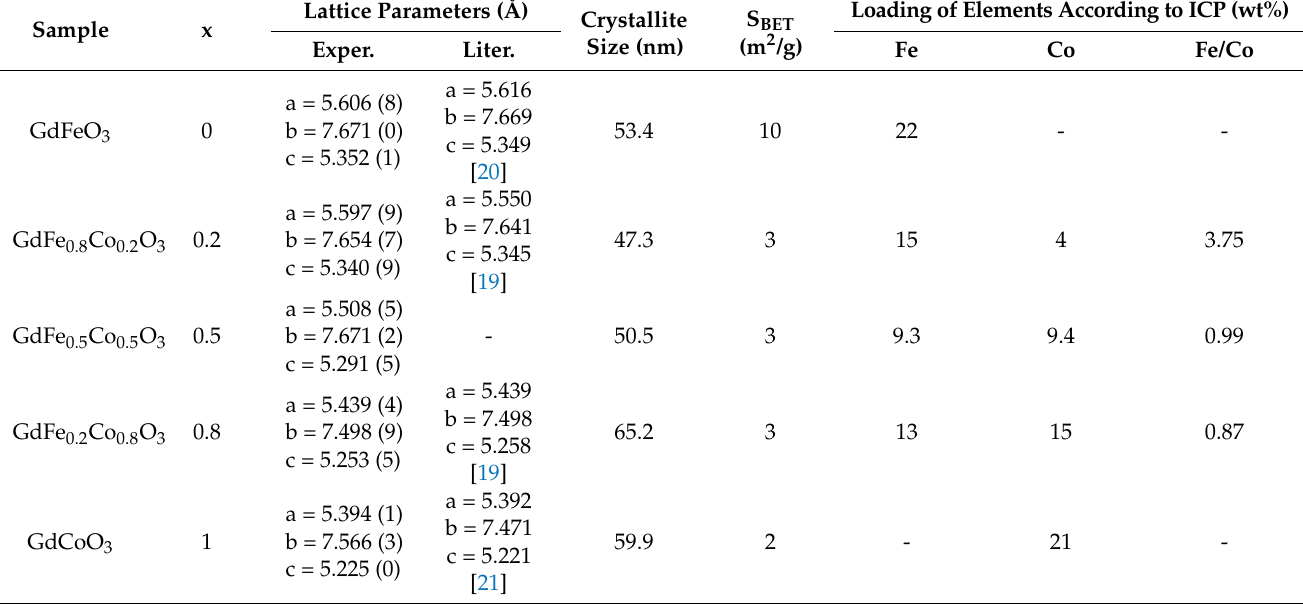
Table 1. The properties of samples